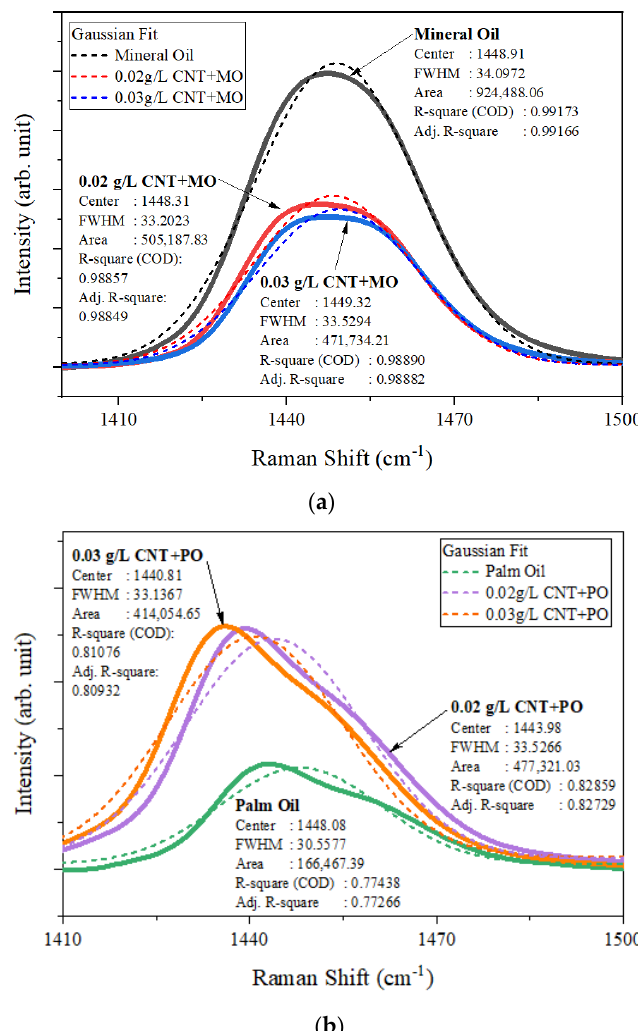
Figure 5. Multiple peak fitting of ( a ) mineral oil, ( b ) palm oil, ( c ) mineral oil with 0.02 g/L CNT, ( d ) mineral oil with 0.03 g/L CNT, ( e ) palm oil with 0.02 g/L CNT, ( f ) palm oil with 0.03 g/L CNT.